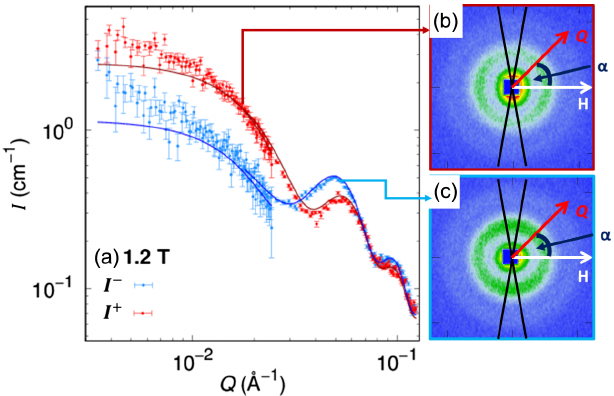
FIG. 12. (a) SANSPOL scattering cross sections I þ and I − recorded at 1.2 T along with refinement (full lines). (b),(c) Corresponding 2D scattering patterns showing the 20 ° sectors around an angle of α ¼ 90 ° between the scattering vector Q and the applied magnetic field H